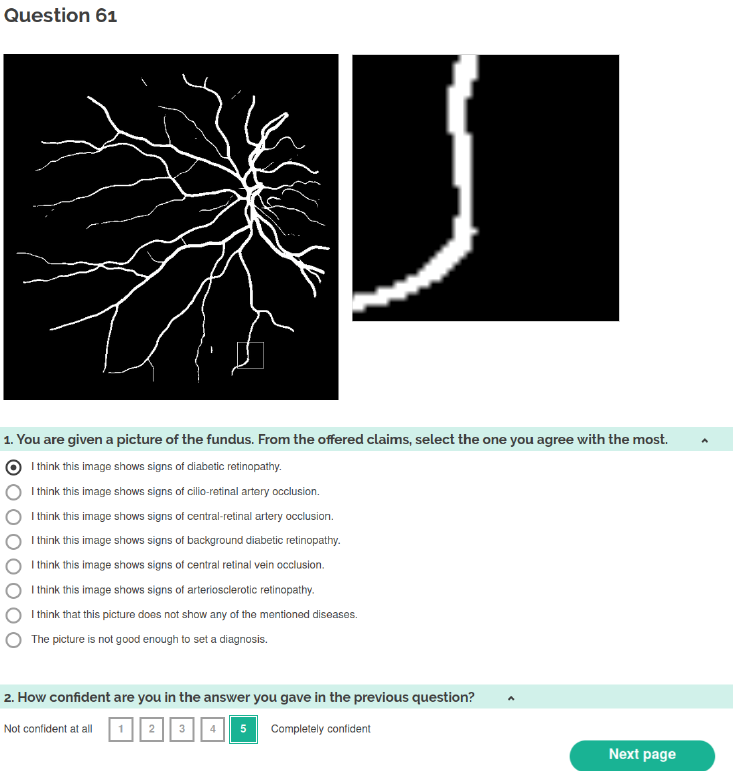
Figure A1. A representative page of the survey used in the first experiment with examples of selected answers.